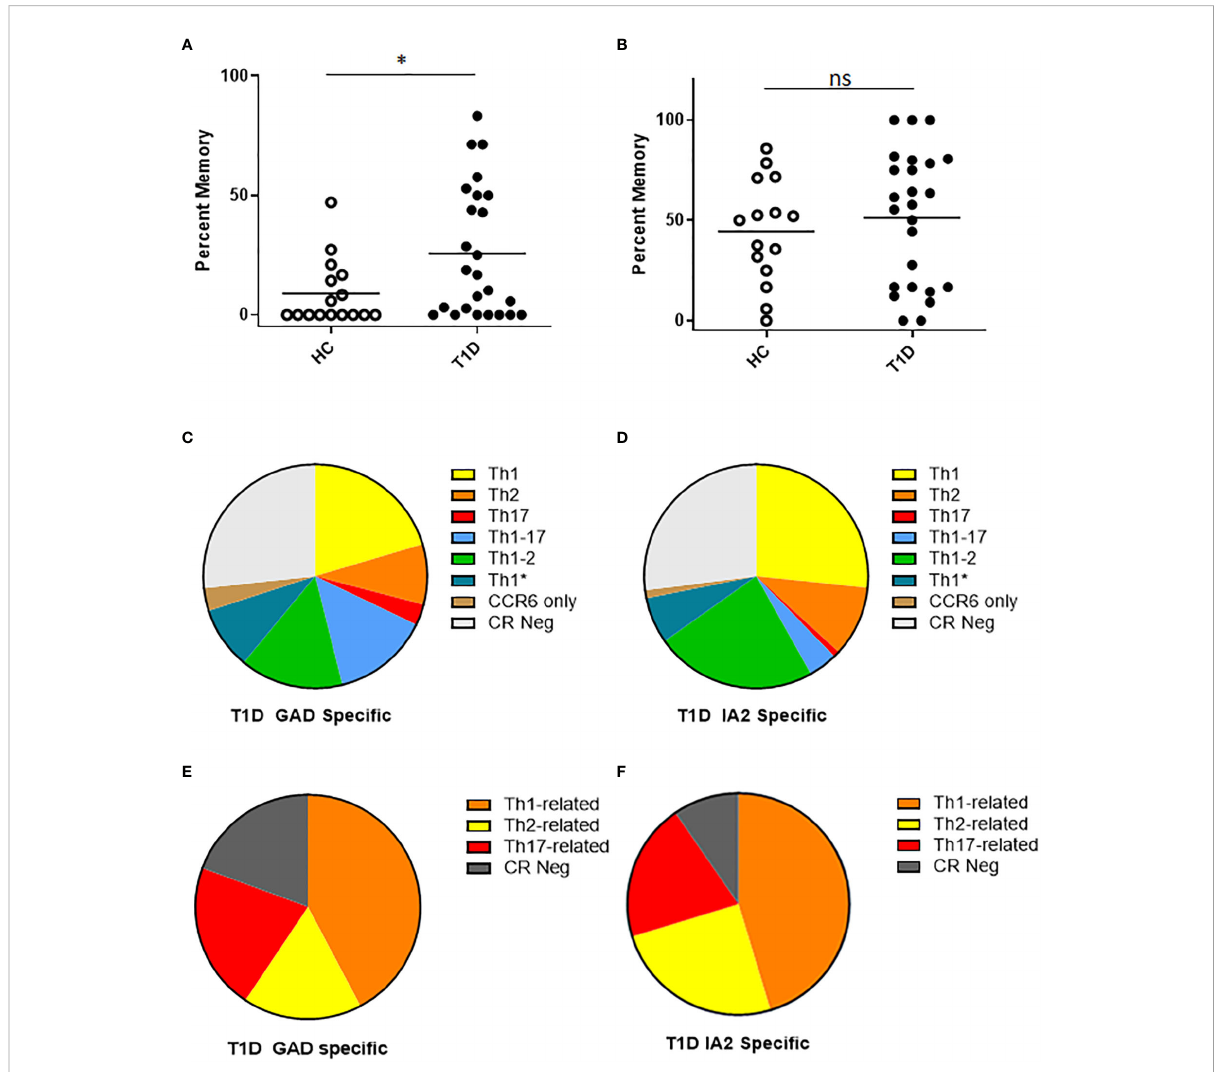
FIGURE 3 T cells speci fi c for PTM GAD epitopes have distinct memory phenotype in subjects with T1D. We characterized the surface phenotype of T cells speci fi c for PTM GAD (DR0401 restricted) and PTM IA-2 (DQ8 restricted) epitopes in 25 subjects with T1D and 15 HLA matched control subjects. (A) De fi ning CD45RA negative cells as conventional memory T cells, the percentage of PTM GAD speci fi c T cells that had a memory phenotype was signi fi cantly higher (p=0.0368, Mann Whitney test) in subjects with type 1 diabetes (black circles) than in healthy controls (white circles). (B) In contrast, the percentage of IA-2 speci fi c T cells that had a memory phenotype did not differ (p=0.47, Mann Whitney test) between subjects with type 1 diabetes (black circles) and healthy controls (white circles). (C) Using combinations of chemokine receptors, the lineage distribution PTM GAD speci fi c memory T cells was examined for subjects with T1D. Taking the average across all subjects, Th1-like cells were predominant (20.3%) followed by Th1-2 (14.9%), Th1-17 (14.0%), Th1* (8.9%), Th2 (8.7%), and Th17 (3.0%); a notable proportion were chemokine receptor negative (27%) and a minor proportion were positive for CCR6 only (3.3%). (D) In the same manner, the lineage distribution of PTM IA2 speci fi c memory T cells was examined for subjects with T1D. Taking the average across all subjects, Th1-like cells were predominant (26.6%) followed by Th1-2 (23.3%), Th2 (10.2%), Th1* (6.7%), Th1-17 (4.2%), and Th17 (0.9%); a notable proportion were chemokine receptor negative (27.0%) and a minor proportion were positive for CCR6 only (1.2%). (E) To juxtapose functional cytokine and surface marker data, we combined observed proportions of interferon- g -associated (Th1, Th1-2, Th1-17, and Th1*) IL-4-associated (Th2 and Th1-2), and IL-17-associated (Th17, Th1-17, Th1*, and CCR6 only) lineage combinations for PTM GAD speci fi c T cells. Taking the average across all subjects, interferon- g -associated cells were predominant (42.2%) followed by IL-17-associated (21.1%), chemokine receptor negative (19.3%), and IL-4-associated (17.1%) cells. (F) In the same manner we combined observed proportions of interferon- g -associated, IL-4-associated, and IL-17-associated PTM IA2 speci fi c memory T cells. Taking the average across all subjects, interferon- g -associated cells were predominant (45.3%) followed by IL-4-associated (24.9%), chemokine receptor negative (20.1%), and IL-17-associated (9.6%) cells. Horizontal lines in each panel indicate the mean value for each group. not signi fi cant (p-value >